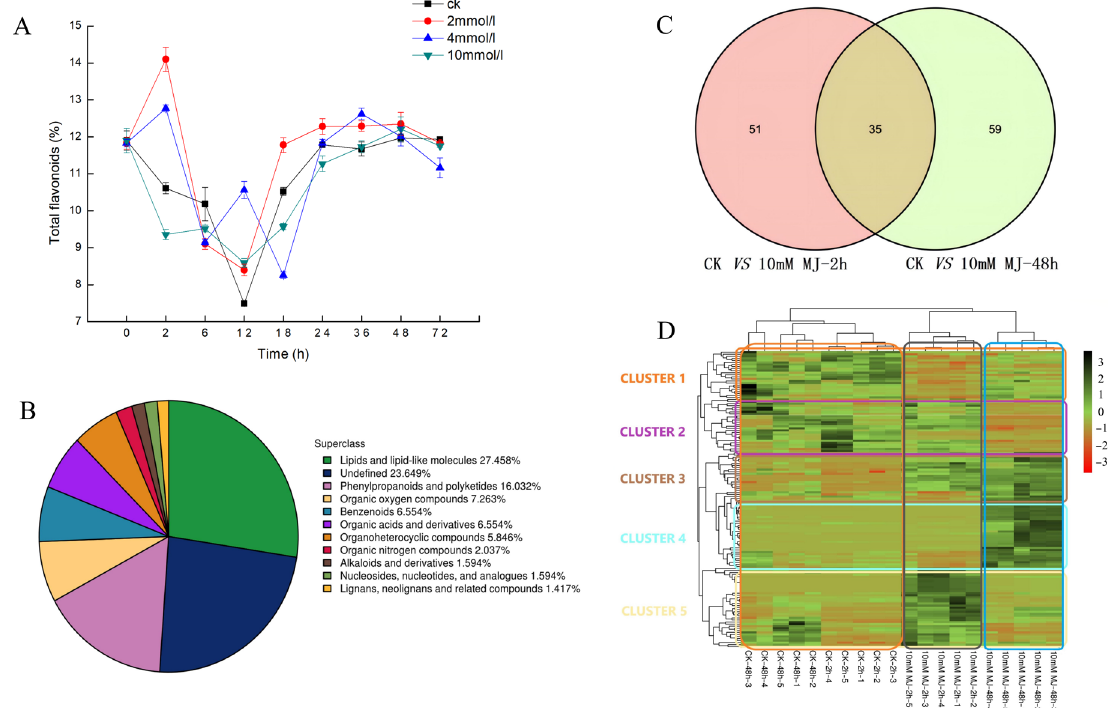
Figure 1. ( A ): Dynamic changes in the content of total flavonoids in C. vietnamensi s under different concentrations of MeJA treatment. ( B ): Quantitative proportions of identified metabolites in each chemical classification. ( C ): Venn diagram of significantly differentially accumulated metabolites between groups (‘ck vs. 10 mM MJ—2 h’ and ‘ck vs. 10 mM MJ—48 h’). ( D ): Heatmap of significantly differentially accumulated metabolites of C. vietnamensis in response to MeJA at different time points (2 and 48 h). Red to green indicates metabolite expression from low to high.